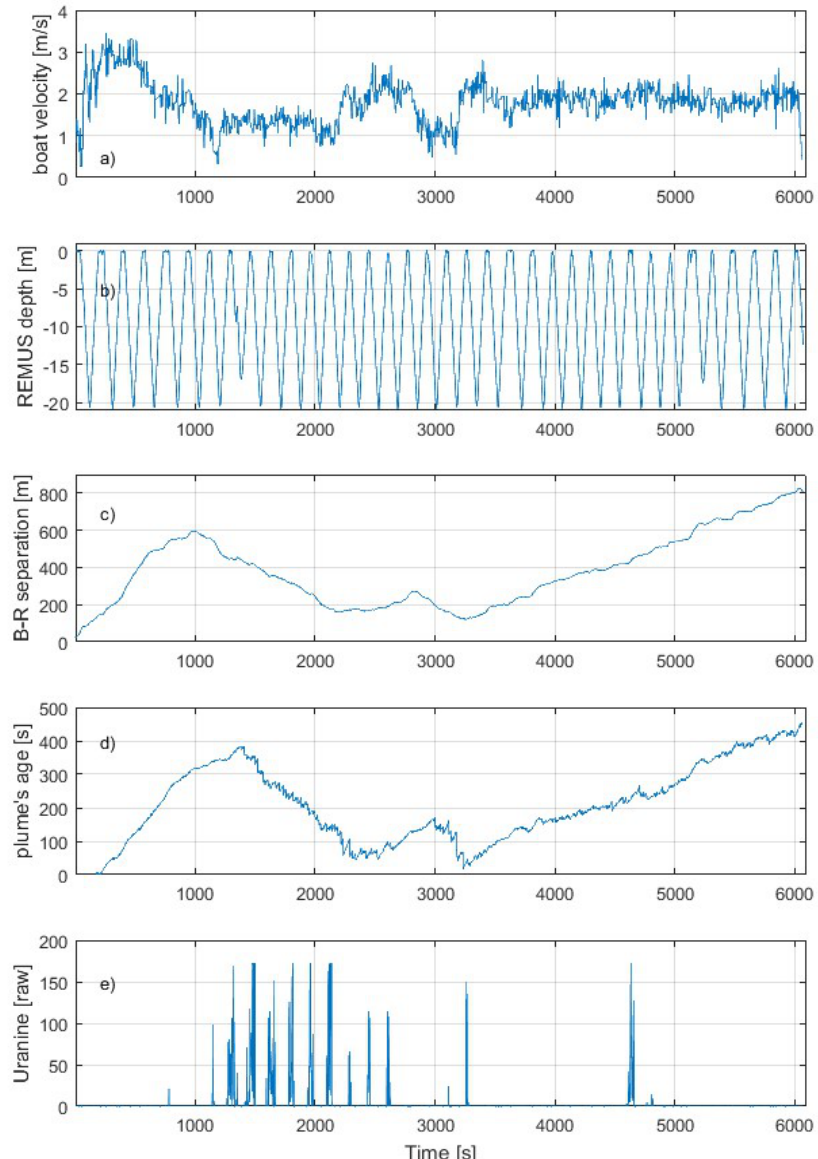
a function of its mission time: ( a ) The velocity of the boat, as it was releasing the dye ahead of the AUV’s track, ( b ) AUV’s depth, ( c ) relative distance between the boat the AUV, ( d ) effective age of the plume sampled by the AUV, ( e ) raw counts of Uranine, as measured by AUV’s fluorometer.